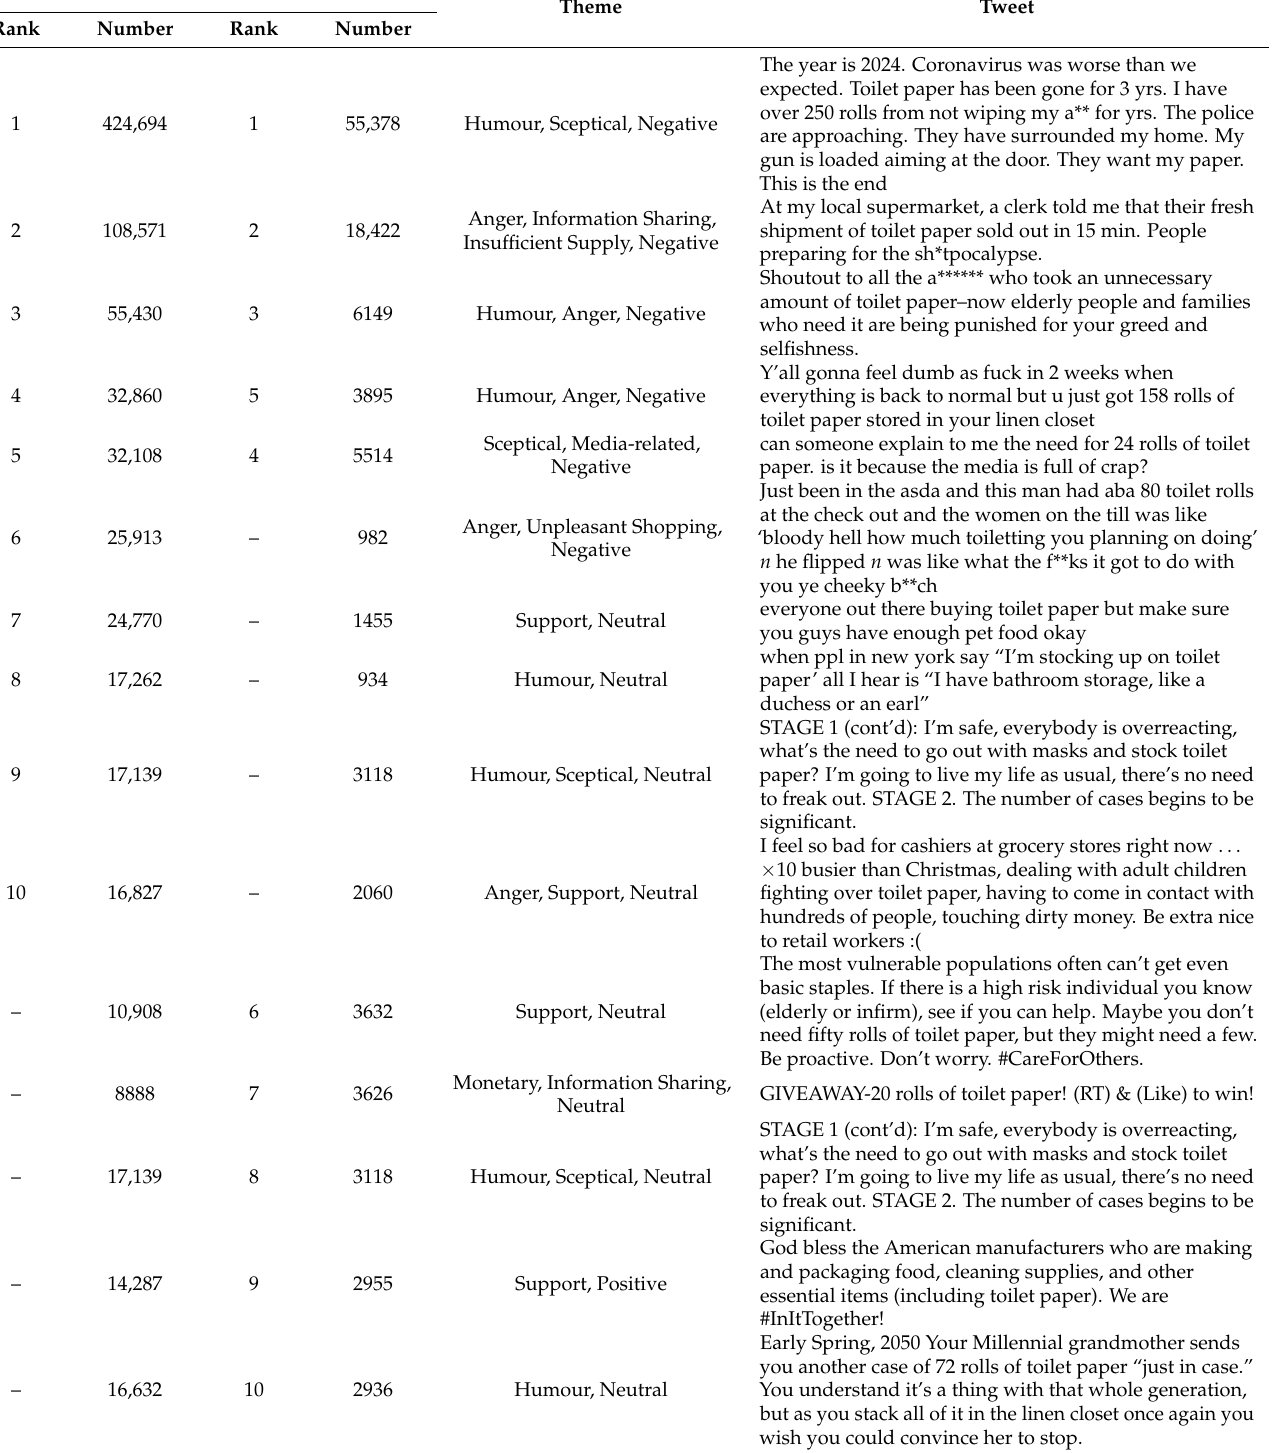
Table 2. Most influential tweets based on retweets and